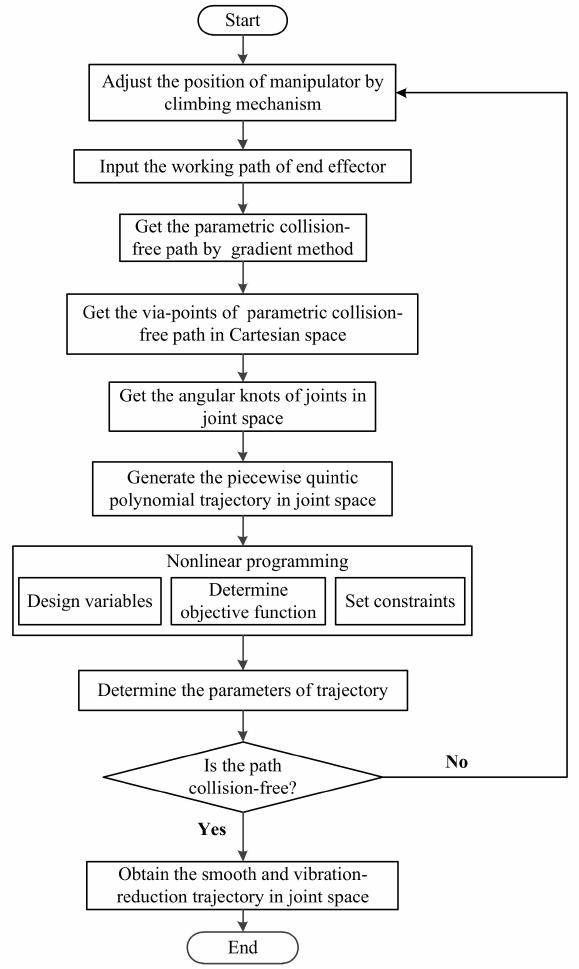
Figure 3. Flowchart of the proposed vibration-reduction motion planning